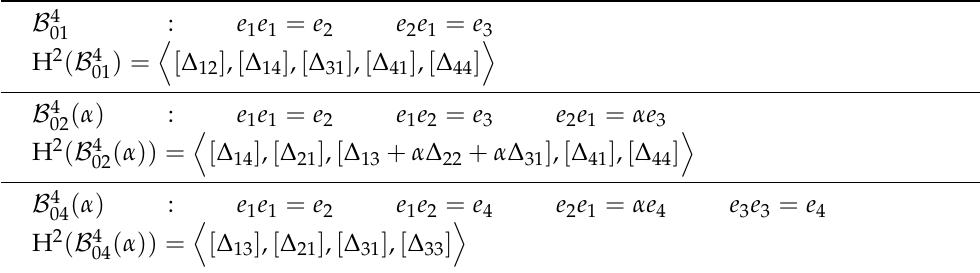
Table 2. The list of non-two-step nilpotent four-dimensional bicommutative algebras. B 4